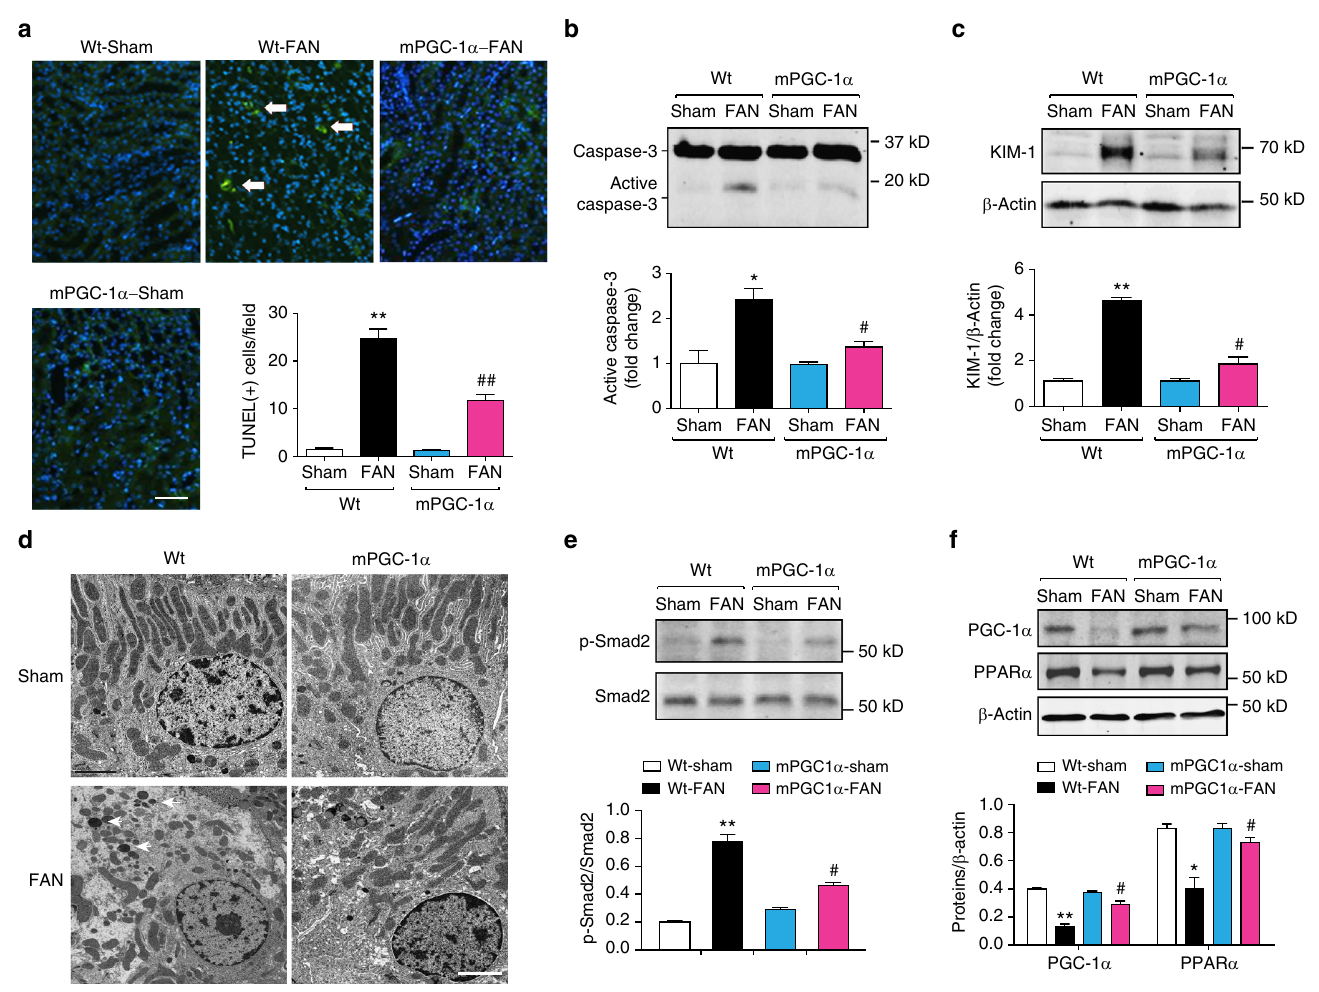
Fig. 2 mPGC-1 α prevents tubule cells damage and activation of TGF- β 1 signaling in kidneys of mice with FAN for 7 days. a Representative images of TUNEL assay revealed an increase in apoptosis in tubules from Wt mice with FAN, this marker of tubule cells damage signi fi cantly reduced in kidneys from mPGC- 1 α mice treated with folic acid. Data were presented as mean ± s.e.m.; ** P < 0.01 for Wt-FAN vs. Wt-Sham and ## P < 0.01 for mPGC-1 α -FAN vs. Wt-FAN ( n = 5 per group, one-way ANOVA with Bonferroni ’ s multiple comparison test). Scale bars, 100 μ m. b Caspase-3 activation (cleaved caspase-3) were evaluated with western blots. Quantitative measurements indicated an increase in cleaved caspase-3 in kidney from Wt mice, and this response was blunted in kidneys of mPGC-1 α mice despite of FAN. * P < 0.05 Wt-FAN vs. Wt-Sham and # P < 0.05 for mPGC-1 α -FAN vs. Wt-FAN ( n = 5 per group, one- way ANOVA with Bonferroni ’ s multiple comparison test). c Western blot of Kidney Injury Marker 1 (KIM-1), its expression was signi fi cantly suppressed in kidneys from mPGC-1 α mice with FAN. ** P < 0.05 for Wt-FAN vs. Wt-Sham and # P < 0.05 for mPGC-1 α -FAN vs. Wt-FAN ( n = 5 per group, one-way ANOVA with Bonferroni ’ s multiple comparison test). d Electron microscopy showed that fragmentation of mitochondria and “ protein droplets ” in proximal tubule cells of Wt mice with FAN (Arrows), these changes were almost eliminated in the tubular cells of mPGC-1 α mice with FAN. n = 5 per group, Scale bars, 2.5 μ m. e Western blots of p-Smad2 in WT and PGC-1 α mice with or without FAN. ** P < 0.05 for Wt-FAN vs. Wt-Sham. # P < 0.05 for mPGC-1 α -FAN vs. Wt-FAN ( n = 5 per group, one-way ANOVA with Bonferroni ’ s multiple comparison test). f The expression of PPAR α and its co-activator (PGC-1 α ) were examined by western blot. Data were presented as mean ± s.e.m.; * P < 0.05 or ** P < 0.01 for Wt-FAN vs. Wt Sham and # P < 0.05 for mPGC-1 α -FAN vs. WtFAN, n = 5 per group (one-way ANOVA with Bonferroni ’ s multiple comparison evaluated apoptosis in kidney tubule cells using a TUNEL assay. Apoptosis rates were signi fi cantly lower in mPGC-1 α mice than